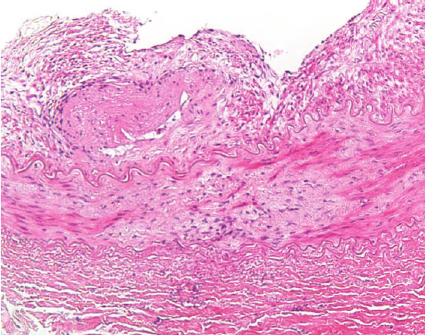
Figure 3: Renal artery biopsy: irregular, “ridgy” thickening of the intima and disruption of the medial layers by proliferation of myofibroblasts (centrally) ( × 10